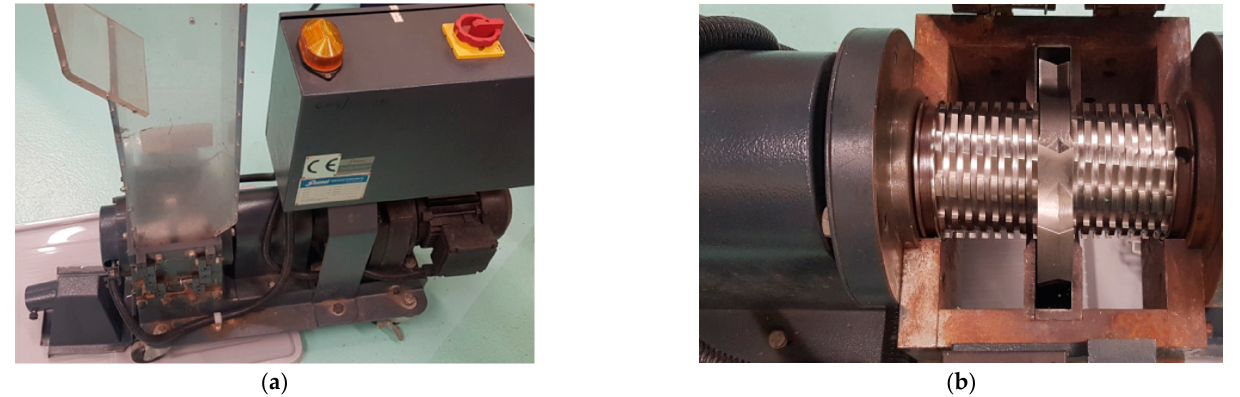
Figure 3. The granulator ( a ) with crushing blades and milling modules ( b ) for grinding the mixed plastic waste. As a result of comminution, polymer fractions with different particle sizes were obtained and subjected to sieve analysis using sieves with nominal dimensions (d) is 4 mm, 2.8 mm and 1.8 mm, as vibratory sieve shaker ANALYSETTE 3 (FRITSCH GmbH, Idar-Oberstein, Germany)(see Figure 4)., four fractions with different particle sizes (smaller than 1.8 mm, between 1.8 and 2.8 mm, between 2.8 and 4 mm and larger than 4 mm) were obtained as a result of the separation (Figure 5). The percentages of the particular fractions of the investigated PET and PE-HD polymers are summarized in Table 1.